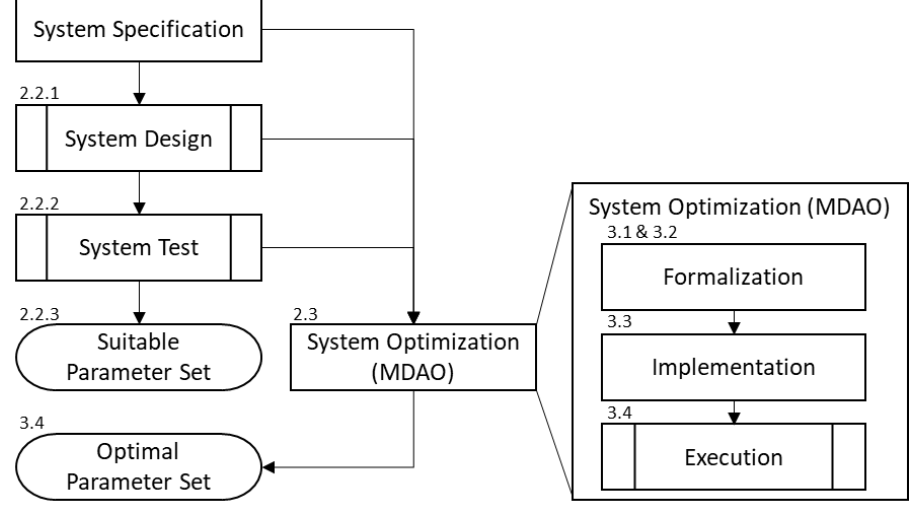
Figure 2. Approach of this paper. Numbers indicate manuscript sections.